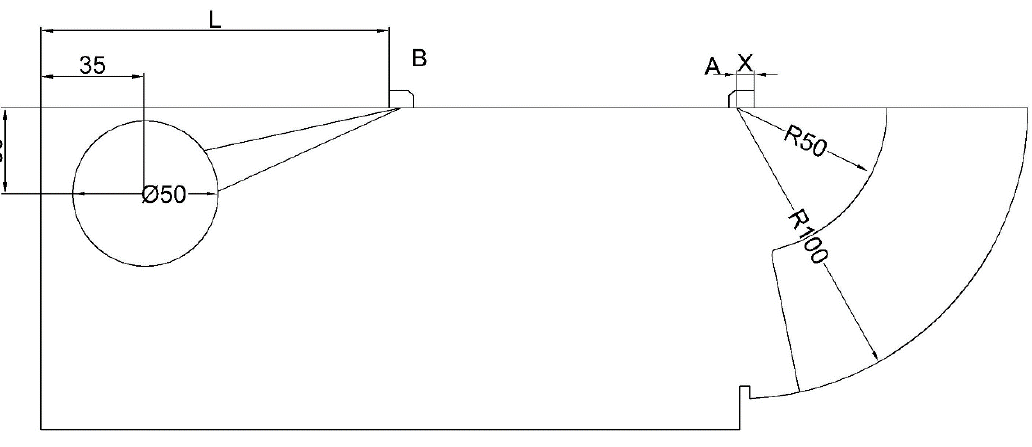
Figure 2. Calibration by CSK ‐ IA block.